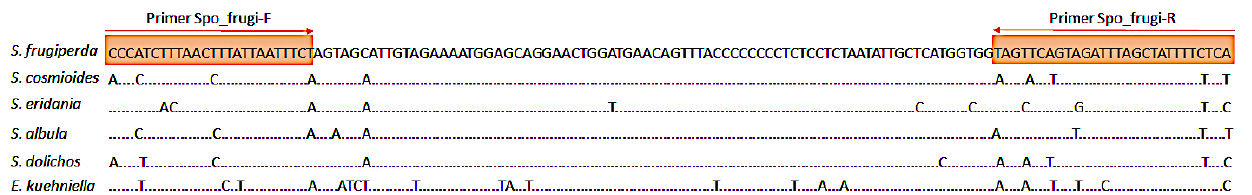
Figure 1. Part of COI gene sequences from Spodoptera frugiperda , Spodoptera cosmioides , Spodoptera eridania , Spodoptera albula , Spodoptera dolichos , and Ephestia kuehniella , aligned to design the pair of primers specific for S. frugiperda . Orange rectangles indicate the pair of forward (Spo_frugi-F) and reverse (Primer Spo_frugi-R) primers. Dots indicate pairs of bases similar to S. frugiperda COI sequences; letters indicate the respective different nucleotide bases in each species.